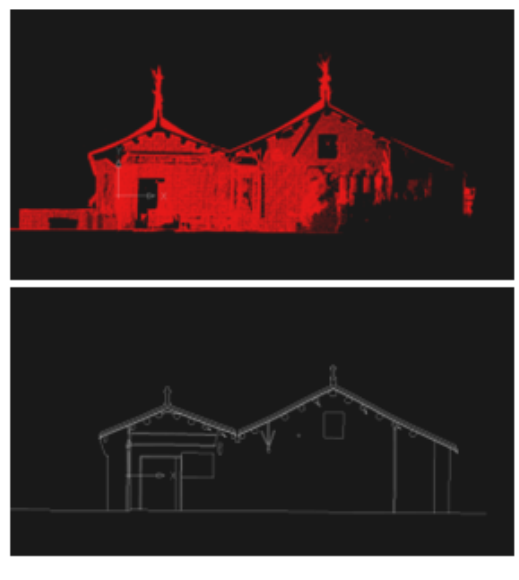
Figure 5. CAD files